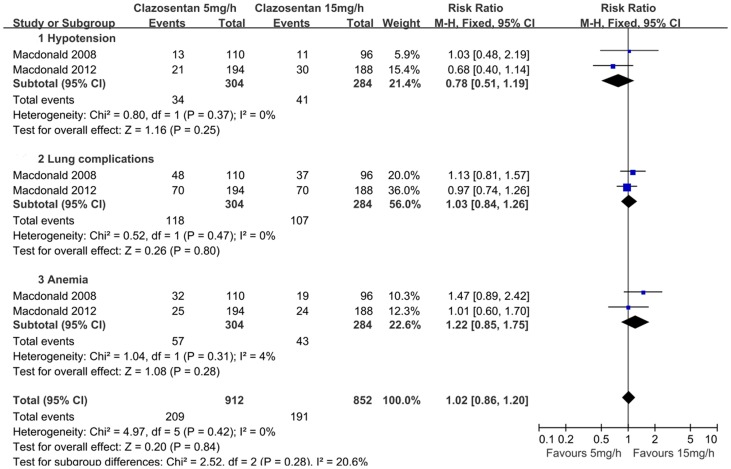
Forest plot on the adverse effects of 5 mg/h and 15 mg/h clazosentan respectively, with subgroup analyses.